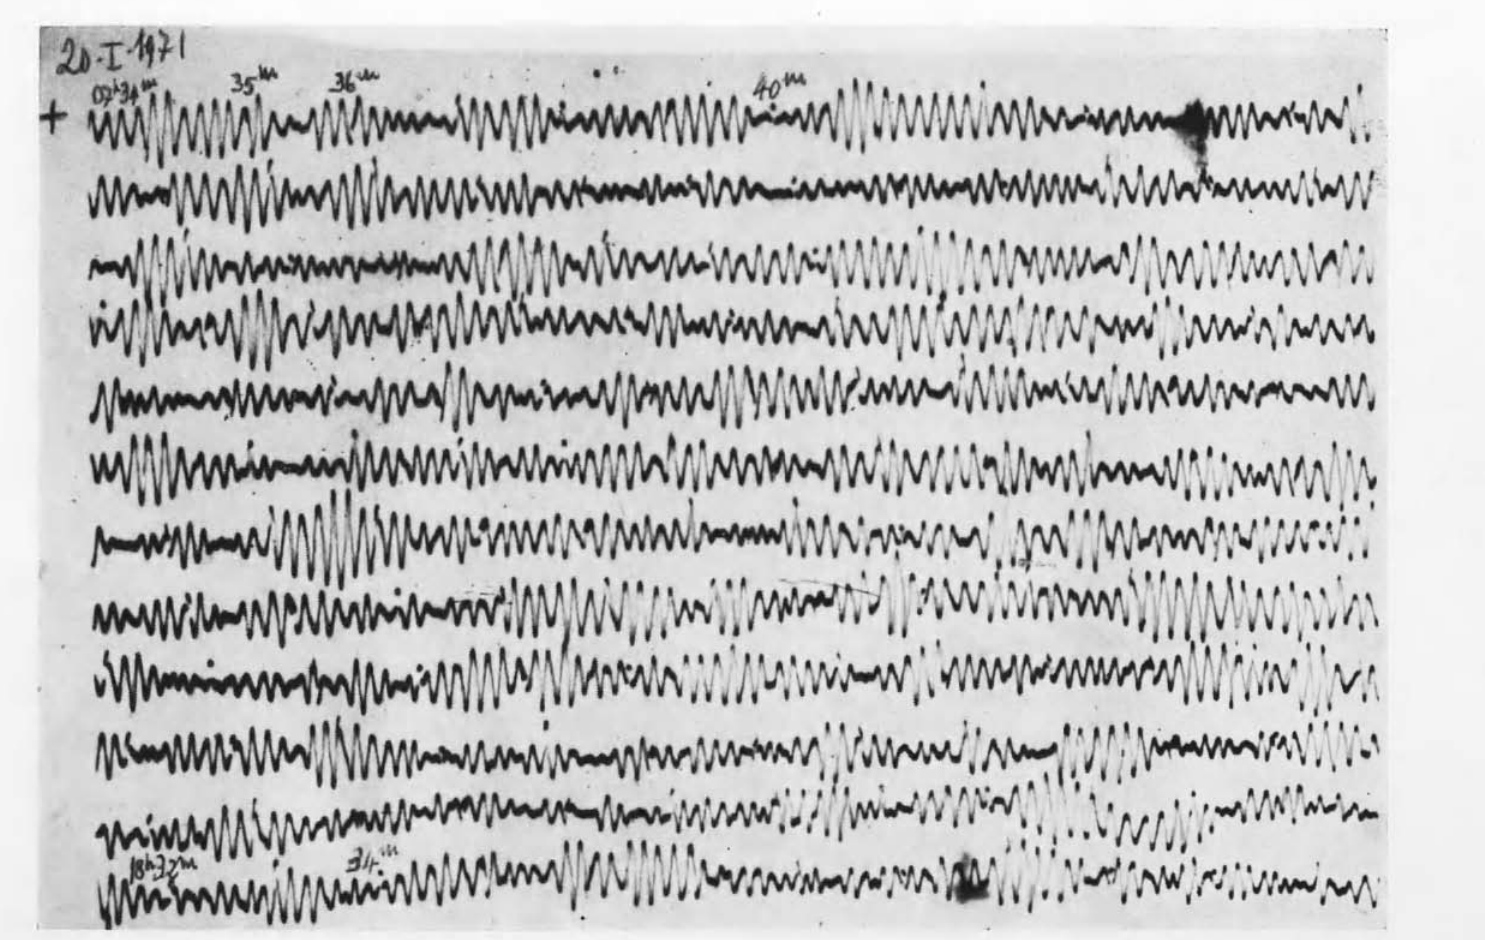
Fig. 3~ - Componente verticale . 1'resB.Ewing" ", a lungo periodo, di Toletlo (T.~r.G.). r sisll\ografi a lungo periodo rli Tolerlo, durant.e i giorni 20 e 21 Gennaio 1971, regist.rano qua.~i eBl'htsivamente, e con grande ampiezza, i microsismi con periodo di